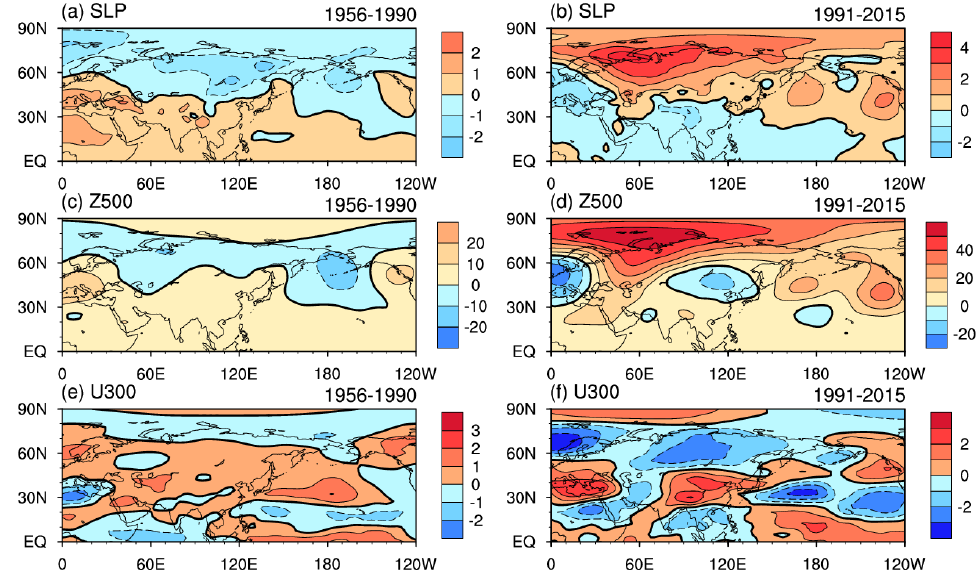
Figure 8. Maps of linear trend of ( a , b ) SLP (hPa · decade − 1 ), ( c , d ) Z500 (gpm · decade − 1 ), and ( e , f ) U300 (m·s − 1 ·decade − 1 ) during 1956–1990 and 1991–2015.